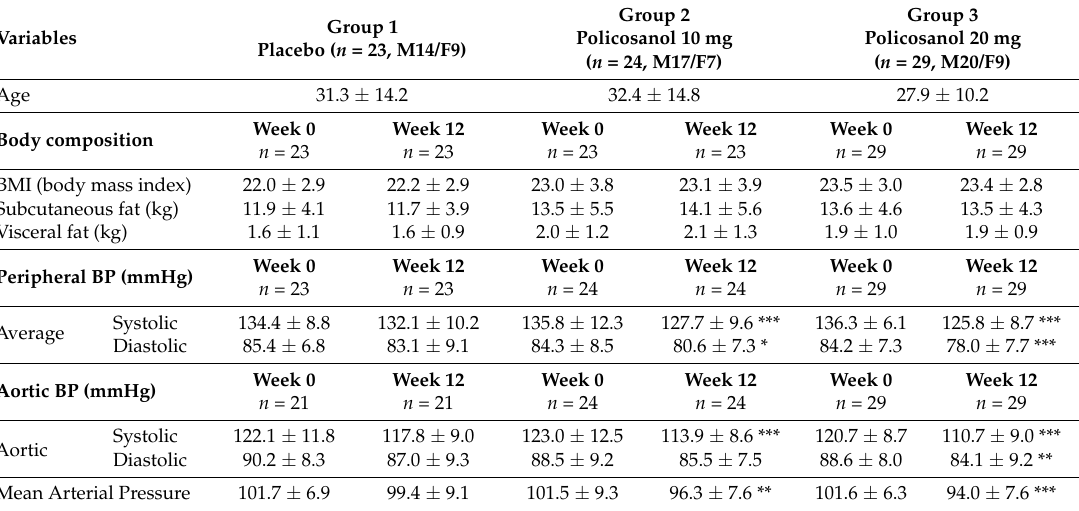
Table 2. Change of blood pressures after 12-week policosanol